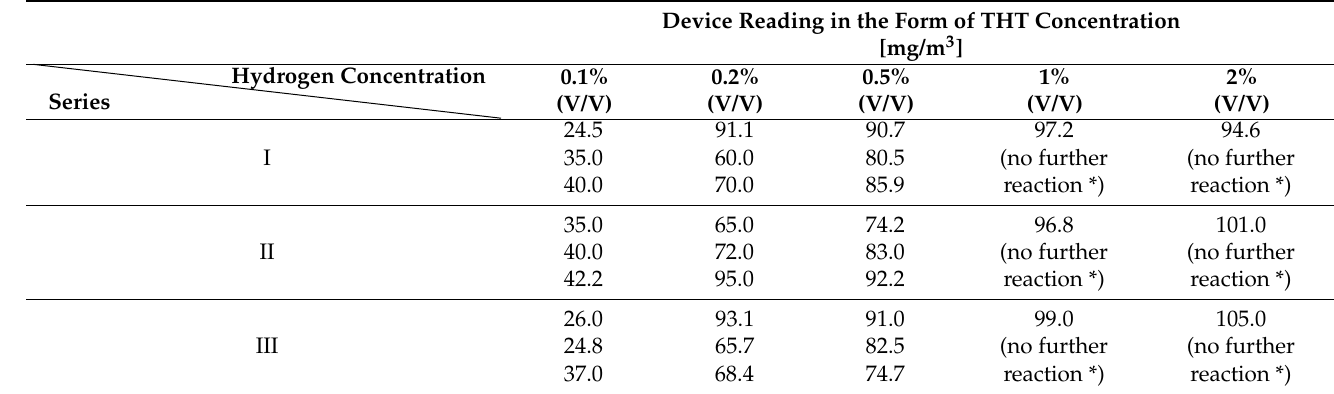
Table 6. List of quality test results involving THT concentration determination in M/H + THT mixtures. Device Reading in the Form of THT Concentration